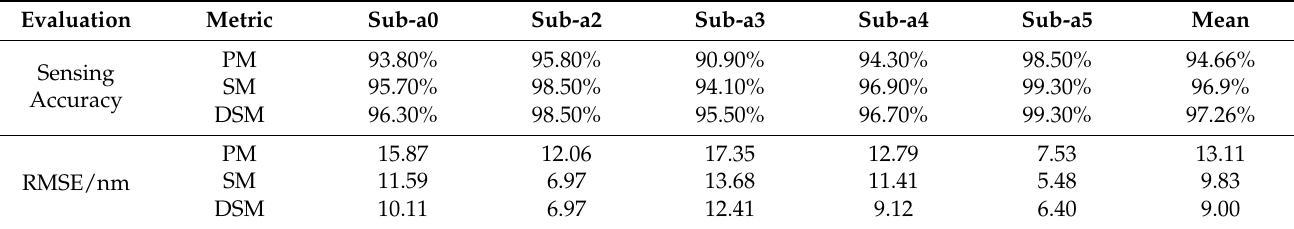
Table 5. The test results of the five sub-apertures that were based on the modified ResNet-34.